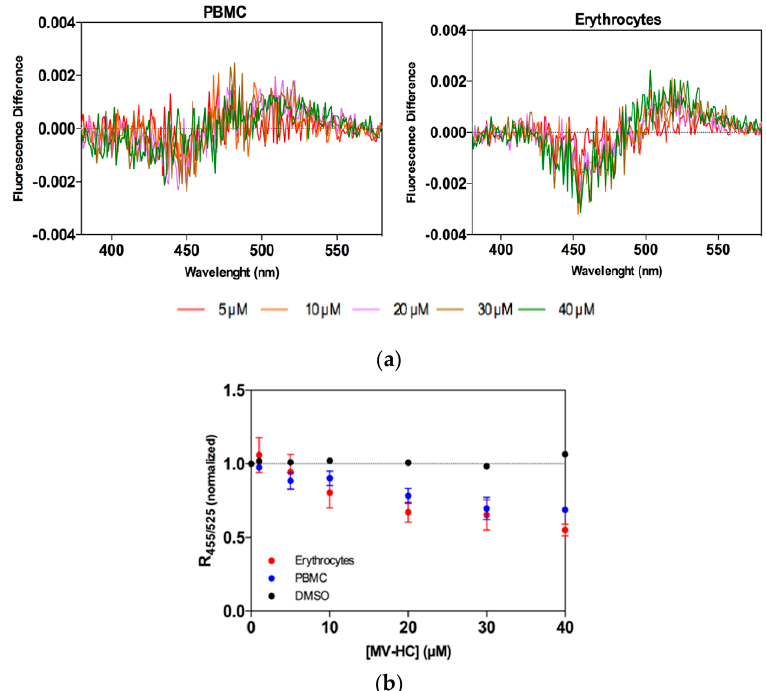
Figure 4. Peptide affinity towards erythrocytes and PBMC assessed by di-8-ANEPPS fluorescence: ( a ) Differential spectra of di-8-ANEPPS bound to cells in the presence of a range of concentrations of MV–HC. Spectra were obtained by subtracting the excitation spectrum (normalized to the integrated areas) of labeled cells in the absence of peptide from those in its presence (different concentrations); ( b ) Binding profiles of MV–HC to erythrocytes and PBMC, obtained by plotting the di-8-ANEPPS excitation ratio, R 455/525 , normalized to the initial value, as a function of the peptide concentration.